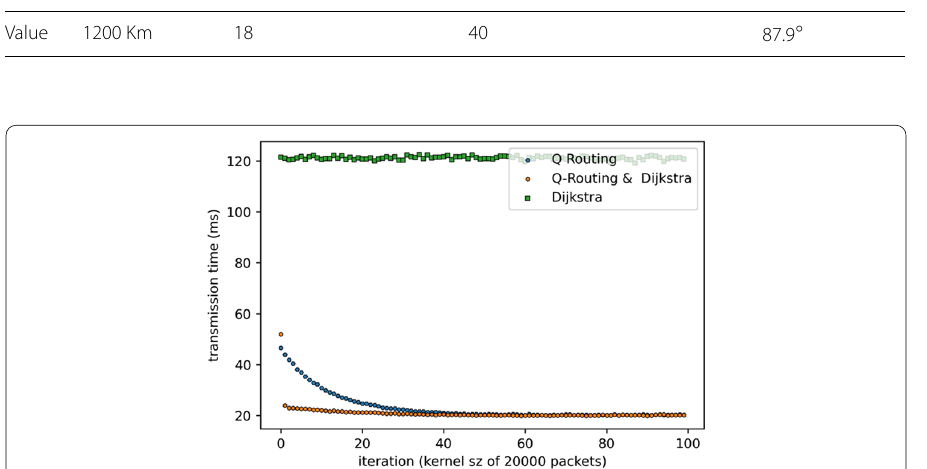
Fig. 7 Routing of 2 million packets using three